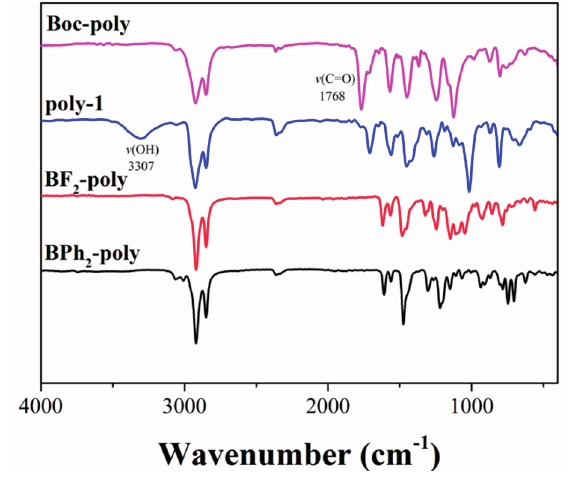
Figure 2. Fourier transform infrared spectroscopy (FT-IR) spectra of the obtained polymers.